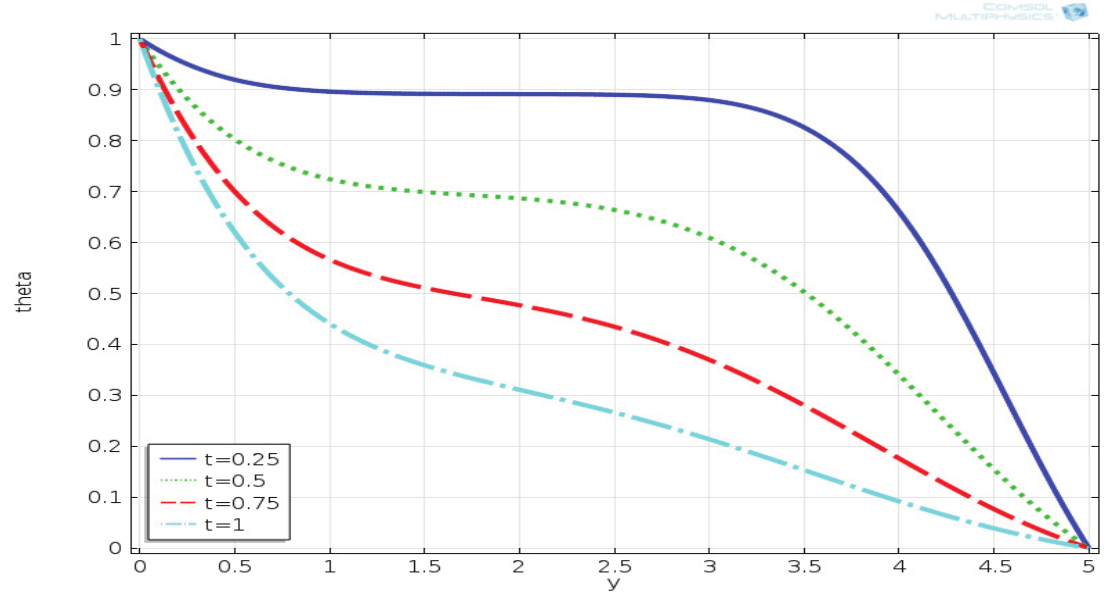
Figure 3: Temperature profiles for different times